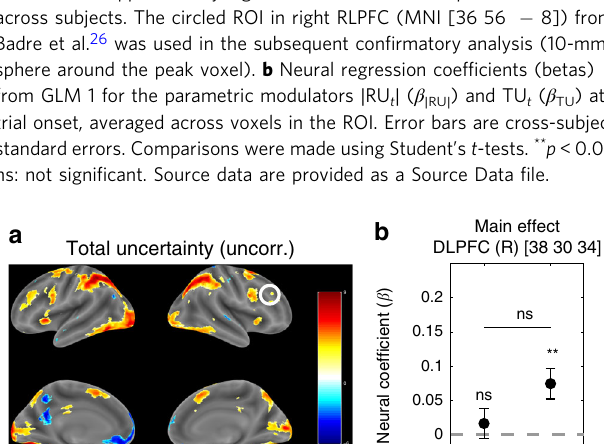
Fig. 4 Right DLPFC tracks total but not relative uncertainty. a Whole- brain TU t contrast from GLM 1. Single voxels were thresholded at p < 0.001. Multiple comparisons correction was not applied (corrected version is shown in Supplementary Fig. 7B). The color scale represents t -values across subjects. The circled ROI in right DLPFC (MNI [38 30 34]) from Badre et al. 26 was used in the subsequent con fi rmatory analysis (10 mm sphere around the peak voxel). b Neural regression coef fi cients (betas) from GLM 1 for the parametric modulators ∣ RU t ∣ ( β ∣ RU ∣ ) and TU t ( β TU ) at trial onset. Error bars are cross-subject standard errors. Comparisons were made using Student ’ s t -tests. ** p < 0.01, ns: not signi fi cant. Source data are provided as a Source Data fi le. effect of relative uncertainty in right RLPFC (MNI [36 56 − 8]) and of total uncertainty in right DLPFC (MNI [38 30 34]). In accordance with their results, in right RLPFC we found a signi fi cant effect of relative uncertainty (Fig. 3b; t (30) = 3.24, p = 0.003, two- tailed t-test) but not of total uncertainty ( t (30) = − 0.55, p = 0.58). The signi fi cance of this difference was con fi rmed by the contrast between the two regressors ( t (30) = 2.96, p = 0.006, paired t -test). Conversely, in right DLPFC there was a signi fi cant effect of total uncertainty (Fig. 4b; t (30) = 3.36, p = 0.002) but not of relative uncertainty ( t (30) = 0.71, p = 0.48), although the contrast between the two did not reach signi fi cance ( t (30) = 1.74, p = 0.09). These results replicate Badre et al. 26 s fi ndings and suggest that relative and total uncertainty are represented in right RLPFC and right DLPFC, respectively.